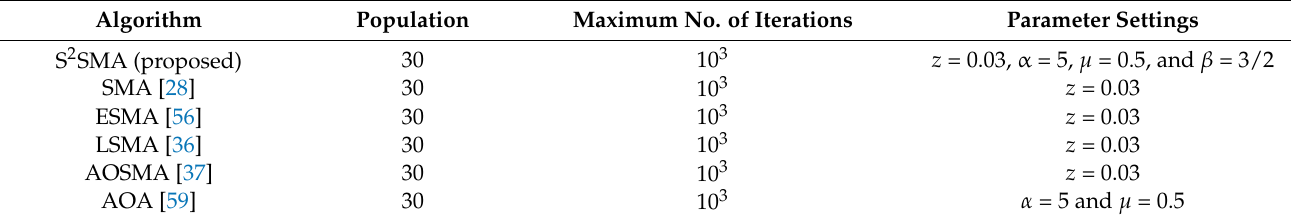
Table 3. Parameter settings for the studied algorithms.